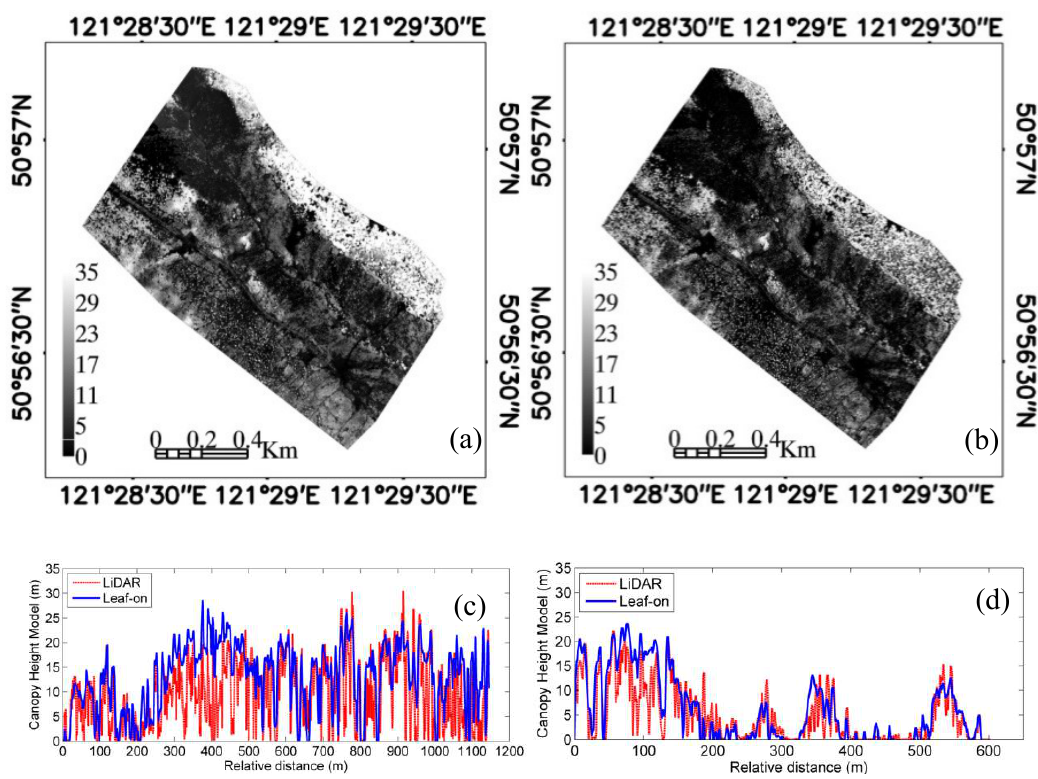
Figure 5. Forest spatial structures extracted by the synergy of point cloud of leaf-on stereo imagery and the filtered point cloud of leaf-off stereo imagery. ( a ) leaf-on UAV mean canopy height model (MCHM), i.e., MCHM extracted from point cloud of leaf-on stereo imagery subtracted by the digital terrain model (DTM) produced by IMF; ( b ) lidar MCHM, the MCHM from lidar data; ( c ) profiles of leaf-on UAV MCHM and lidar MCHM along the same line as Figure 4d; ( d ) profiles of leaf-on UAV MCHM and lidar MCHM along the same line as Figure 5e.